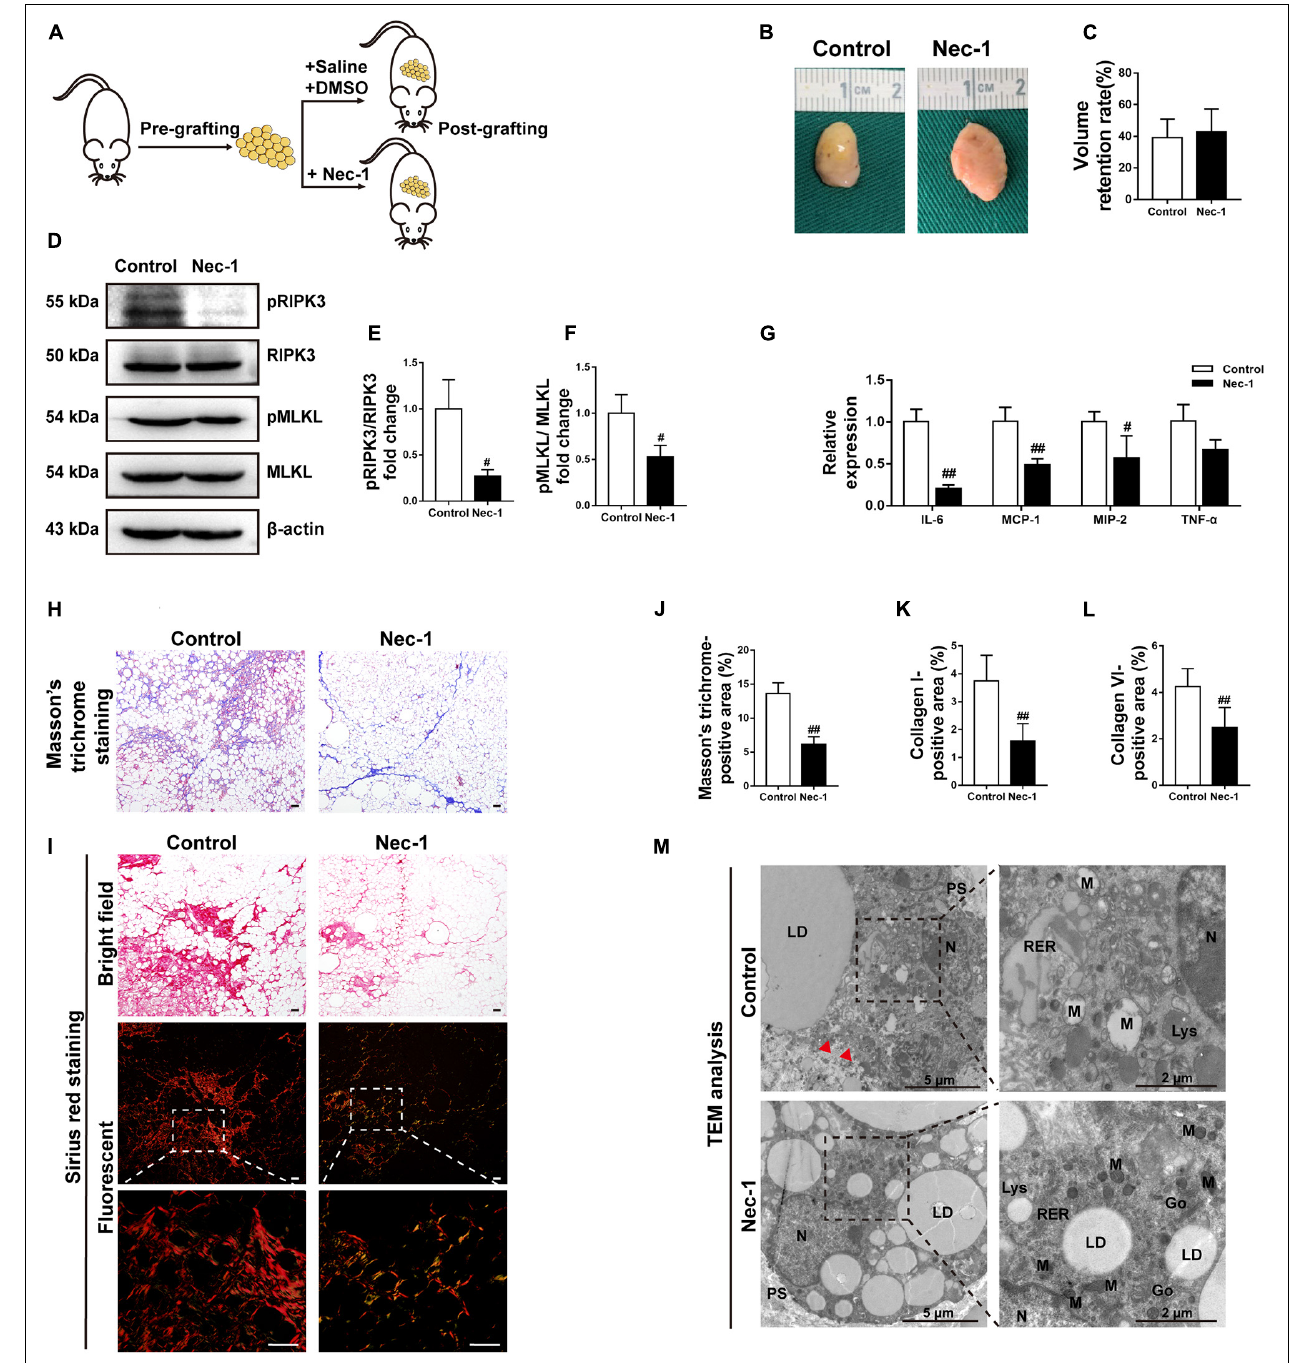
FIGURE 8 | Blockade of necroptosis alleviates fat graft fibrosis. (A) Illustration of the animal model. Fat grafting model mice were administered Nec-1 or vehicle. (B) Macroscopic views of harvested fat tissue. (C) The retention volume of the fat grafts over time. (D–F) Western blot analyses of MLKL, pMLKL, RIPK3, and pRIPK3 in vivo . (G) The gene expression level of the cytokines TNF- α and IL-6 and the chemokines MCP-1 and MIP-2 in fat grafts. (H) Representative Masson’s trichrome staining of fat tissue at week 16 after grafting in the different groups. (I) Representative Sirius red staining of fat tissue at week 16 after grafting in the different groups. (J–L) Quantification of the areas positive for Masson’s trichrome (J) , collagen I (K) , and collagen VI (L) staining in fat tissue at week 16 after grafting in the different groups. Scale bars = 50 µ m. Data are presented as the mean ± SD. # P < 0.05, ## P < 0.01 compared with the control group. (M) TEM analyses of the ultrastructure of MFCs in fat tissue at week 16 after grafting in the different groups. N, nucleus; LD, lipid droplet; PS, pseudopodia; M, mitochondria; RER, rough endoplasmic reticulum; Go, golgiosome; Lys, lysosome; and Red arrowheads indicated the damaged plasma membrane.